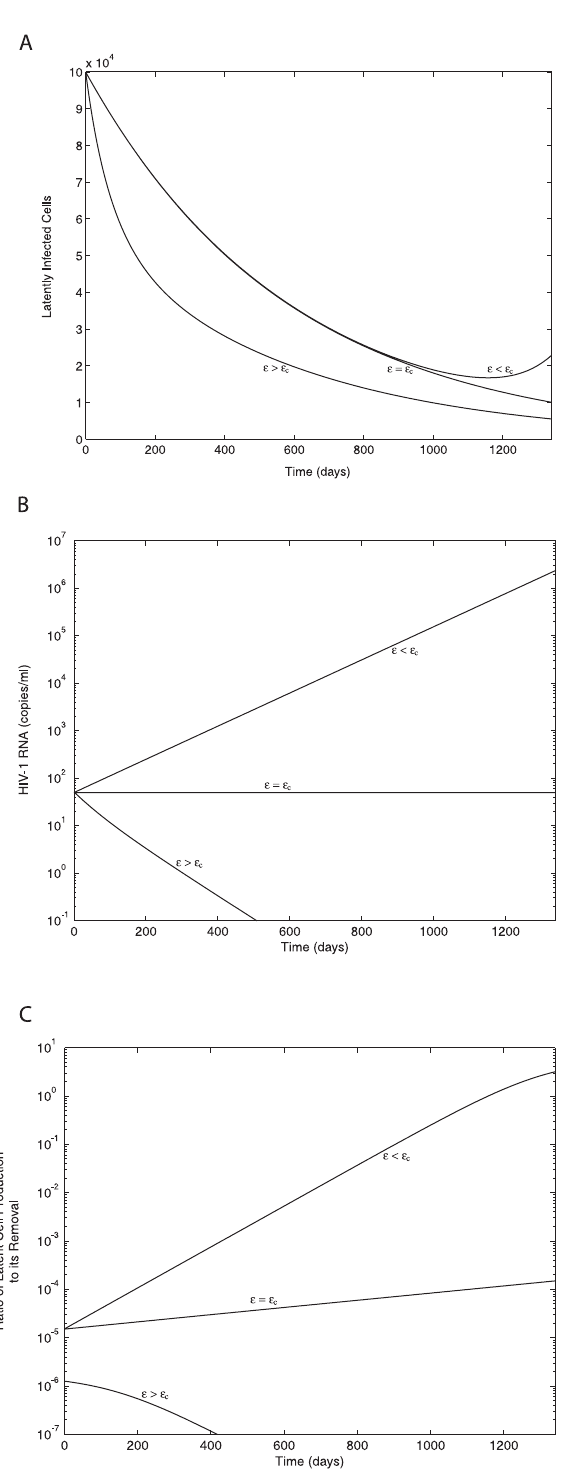
Figure 4. Effect of Ongoing Viral Replication ( e , 1) on the Latent Reservoir, Plasma Viral Load, and the Contribution of Ongoing Viral Replication to the Level of the Latent Reservoir Measured by the Ratio of the Rate of Production of Latently Infected Cells by Ongoing Viral Replication to the Net Removal Rate of Latently Infected Cells The results were obtained for e values above ( e ¼ 0.7 . e c ), at ( e ¼ 0.1402 ¼ e c ), and slightly below ( e ¼ 0.133 , e c ) the critical drug efficacy ( e c ) when a min ¼ 0, r ¼(cid:1) 0.00171 d (cid:1) 1 , and x ¼ 0.00939 d (cid:1) 1